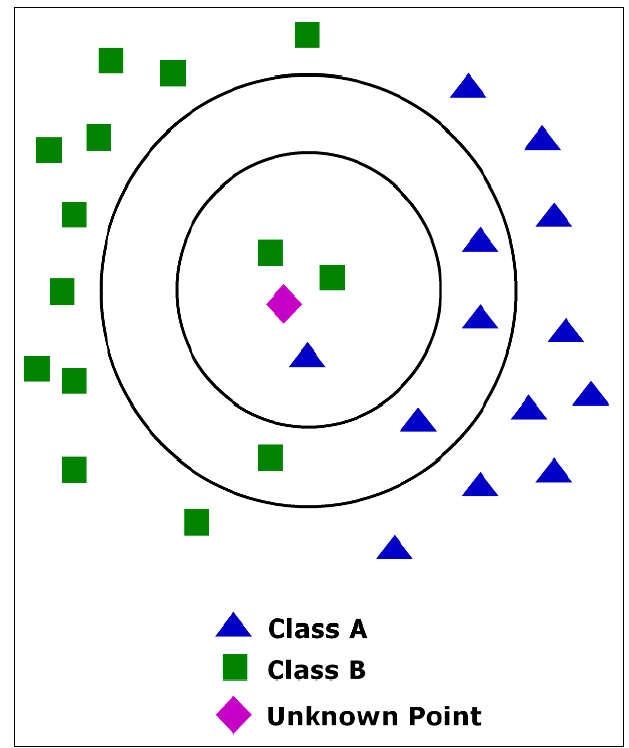
Figure 7. KNN clustering